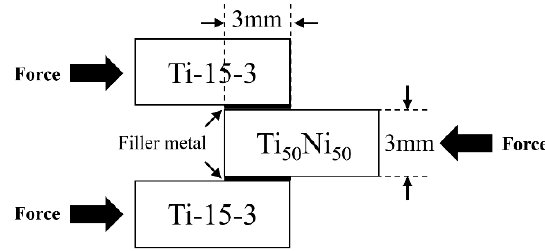
Figure 2. Illustration of the shear test sample and applied forces in shear test.